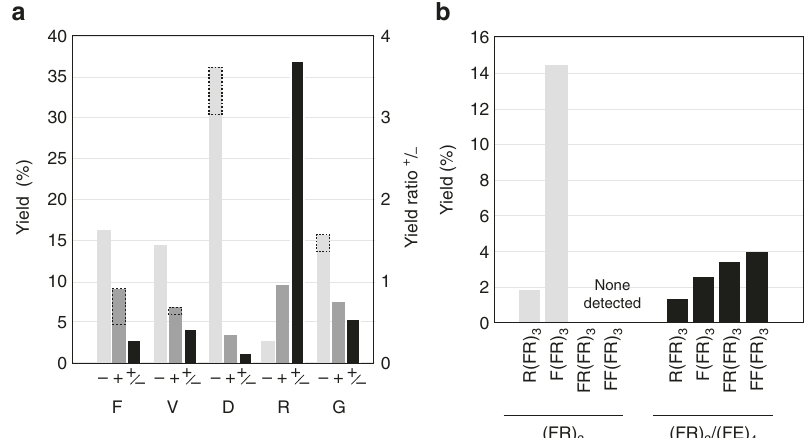
Fig. 3 Sequence-speci fi c, consecutive double addition reactions with the (FR) 3 /(FE) 4 amyloid. a Product yields in addition reactions with the individual amino acids phenylalanine, valine, aspartate, arginine and glycine. The yields for the reactions without template are in light gray, with template in gray and their ratio plotted on a different scale (right axis) is in black. The double addition products are outlined with the dotted lines. b Product yields in a mixture of arginine and phenylalanine. For all reactions, the (FR) 3 concentration was 100 μ M, the (FE) 4 concentration was 130 μ M and individual amino acids were